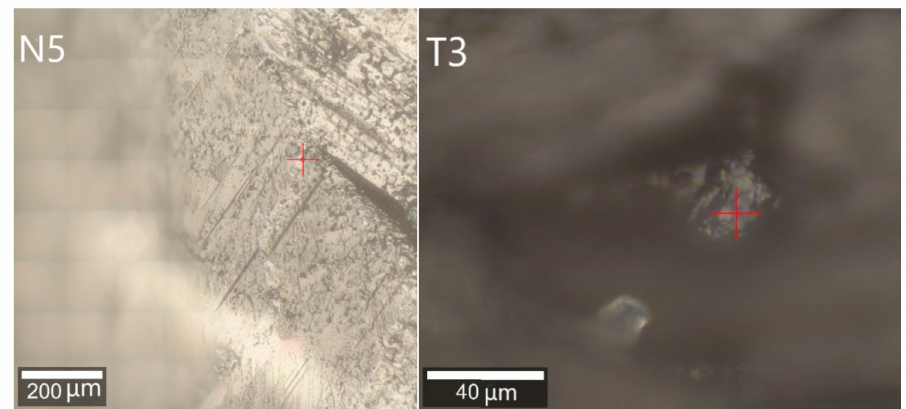
Figure 3. Location and morphology of calcite inclusions in tanzanite samples N5 and T3.